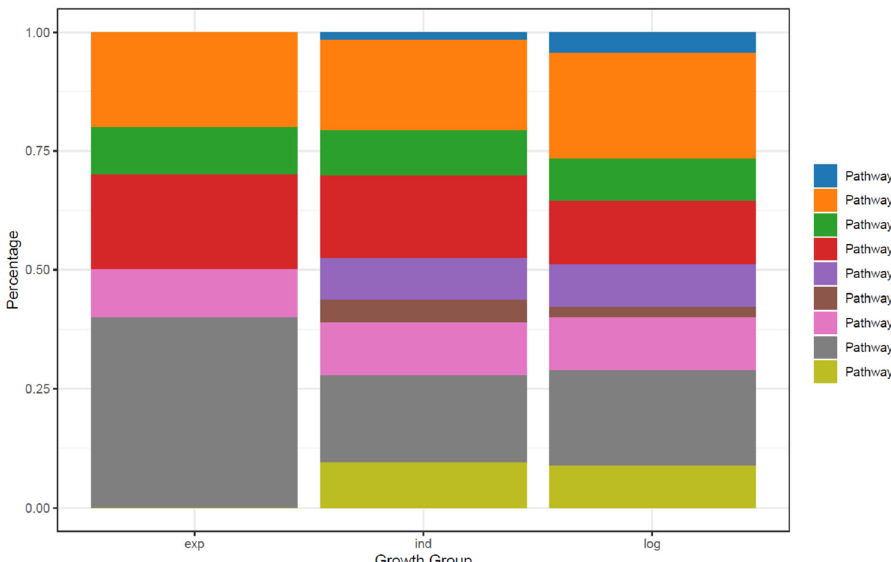
Fig. 5 Percentage of persons with driver mutations altering a signaling pathway. Pathway 1; Chromatin modi fi cation: ZMYM3, Pathway 2; DNA damage: ATM, POT1, TP53, CCND2, Pathway 3; Apoptosis: BIRC3, TP53, Pathway 4; Notch signaling: FBXW7, NOTCH1, Pathway 5; In fl ammatory pathway: BIRC3, DDX3X, MYD88, TRAF3, Pathway 6; MAPK, ERK, BRAF, KRAS, NRAS, TRAF3, Pathway 7; NFkB pathway: BCOR, BIRC3, EGR2, IRF4, NFKBIE, Pathway 8; RNA and ribosomal processing: DDX3X, MED12, NXF1, RPS15, SF3B1, XPO1, ZNF292, Pathway 9; MYC related: FBXW7,